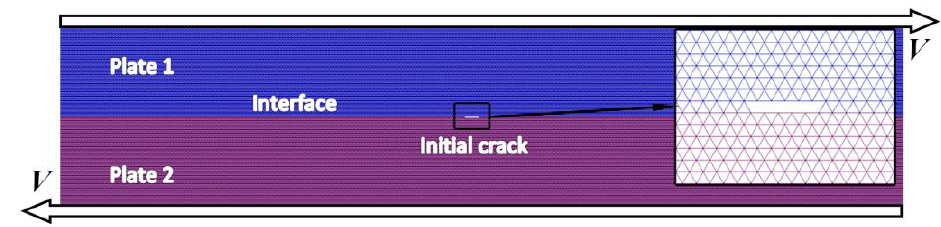
Fig. 1. Structure of the sample and the loading